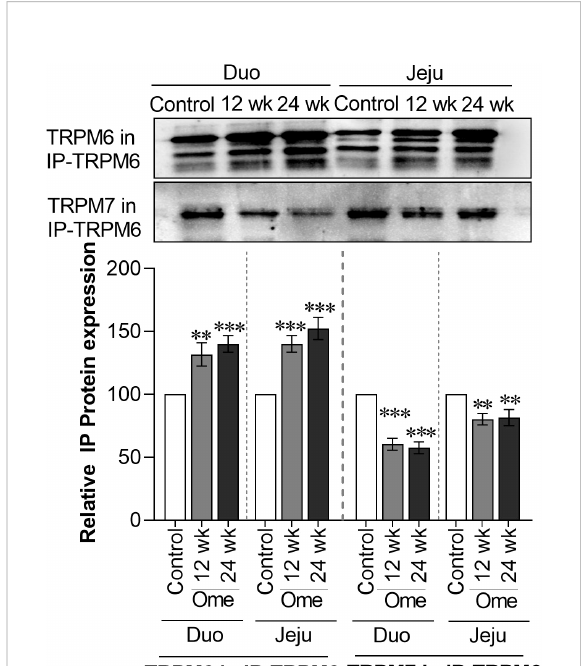
FIGURE 4 Membrane TRPM6 and TRPM7 expression from immunoprecipitated (IP)-TRPM6 sample from duodenal and ileal tissues of control or omeprazole-treated rats. Duo, duodenum; Jeju, jejunum. ** P < 0.01, *** P < 0.001. ( n =